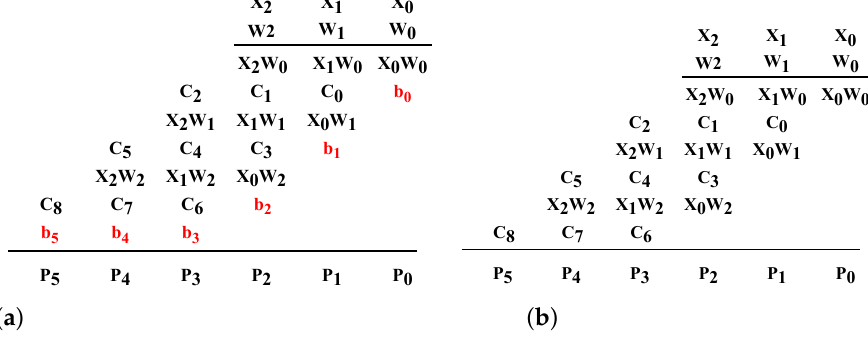
Figure 5. ( a ) Multiplication process of design-I. ( b ) Multiplication Process of